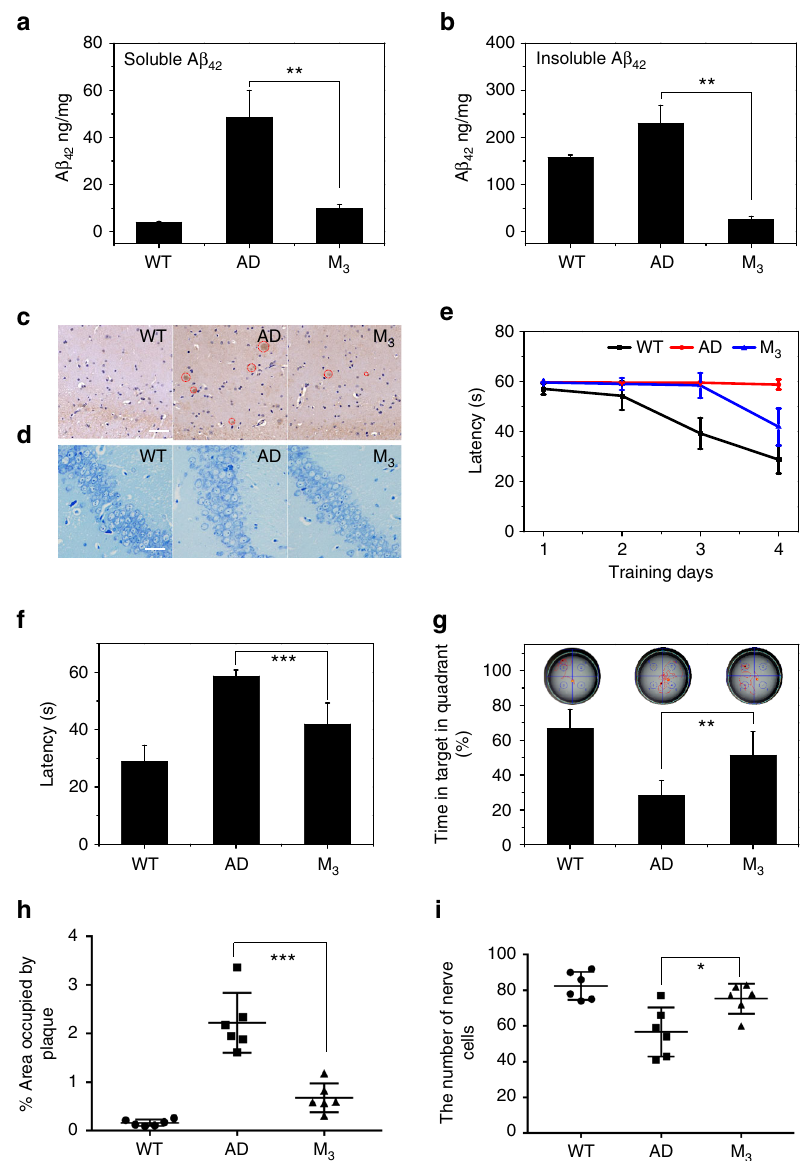
Fig. 8 In vivo evaluation of M 3 for the clearance of A β and decreasing cytotoxicity. a Soluble A β 42 and ( b ) insoluble A β 42 in the brain measured by ELISA. ( n = 4). c The immunohistochemical analysis of A β 42 deposition in the brains of WT control mice, AD control mice, AD mice treated with M 3 . The A β 42 deposits appeared as brown signals as indicated by red dotted circle. Scale bar is 50 µ m. d The Nissl staining of nerve cells in the brains of WT control mice, AD control mice, AD mice treated with M 3 . The Nissl bodies were stained blue. Scale bar is 50 µ m. e The latencies of WT control mice, AD control mice, and AD mice treated with M 3 (three mice per group). f The latency during the memory test in the MWM probe trial without a platform. g The percent (%) of time in the targeted quadrant where the platform had been located during the memory test in the MWM probe trial. h , i were the quanti fi ed results of ( c , d ), respectively. Data are presented as mean ± s.d. ( n = 6). The data between AD group and M 3 group are analyzed by a Student ’ s t -test. Statistical signi fi cance is indicated as * p < 0.05, ** p < 0.01, and *** p <